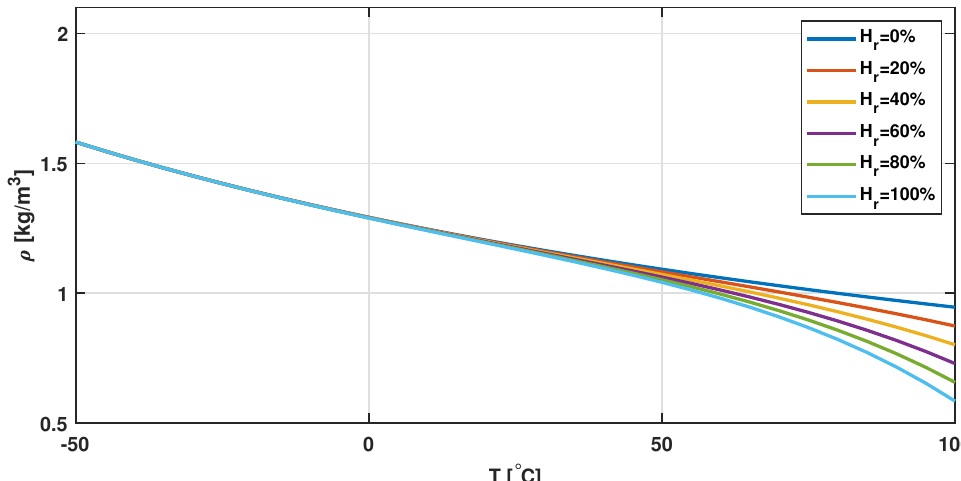
Figure 2. Temperature vs. air density with varying humidity.